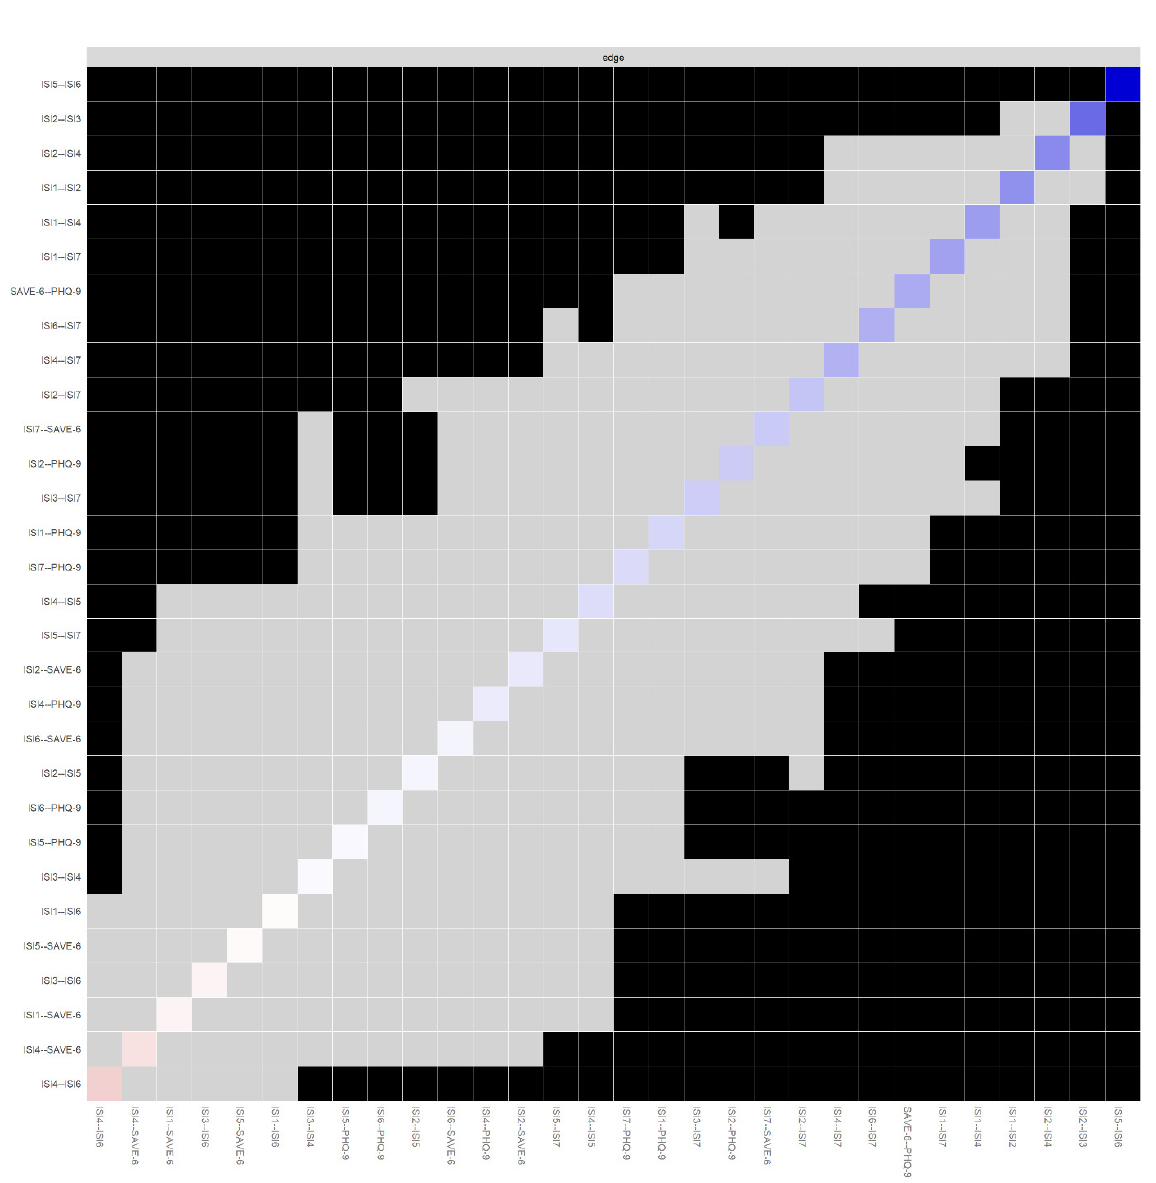
Figure 4. Results for bootstrapped difference tests of all edges, ordered by weight. Note. Black boxes indicate significant difference, while gray boxes indicate non-significant difference between edges located on the corresponding x and y-axis. The color of diagonal boxes indicate the strength and direction of its corresponding edge. Blue indicates positive and red indicates negative edge. Darker color indicates stronger edge. More numbers of black boxes with regard to an edge indicate that it is significantly stronger than most other edges.